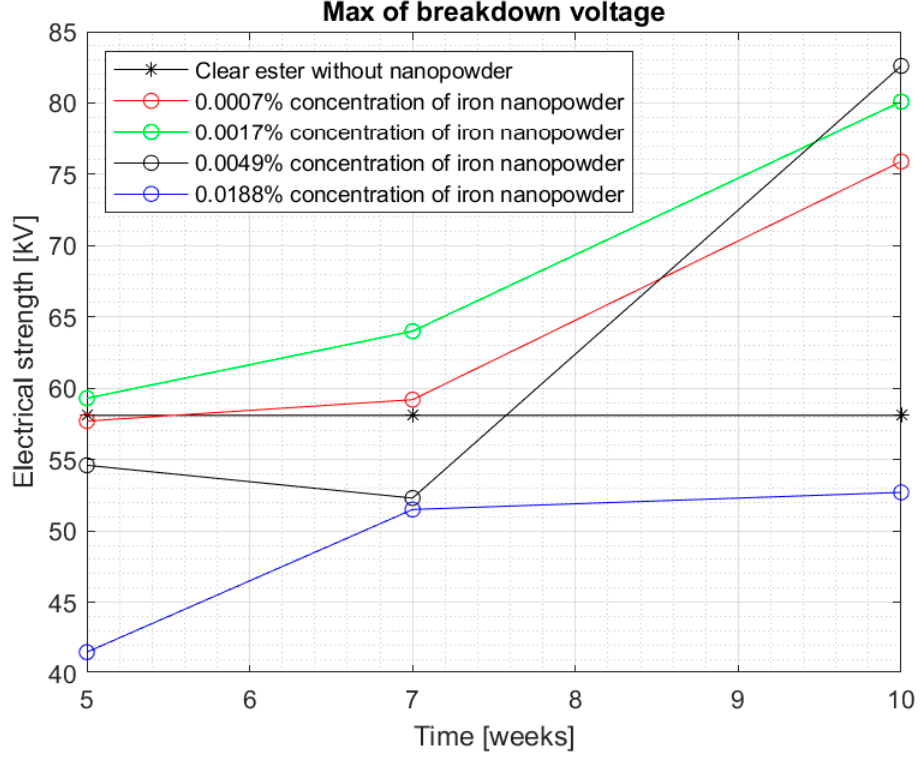
Figure 11. Maximum breakdown voltage values achieved for di ff erent nanoparticle concentration in the doped ester from five to ten weeks